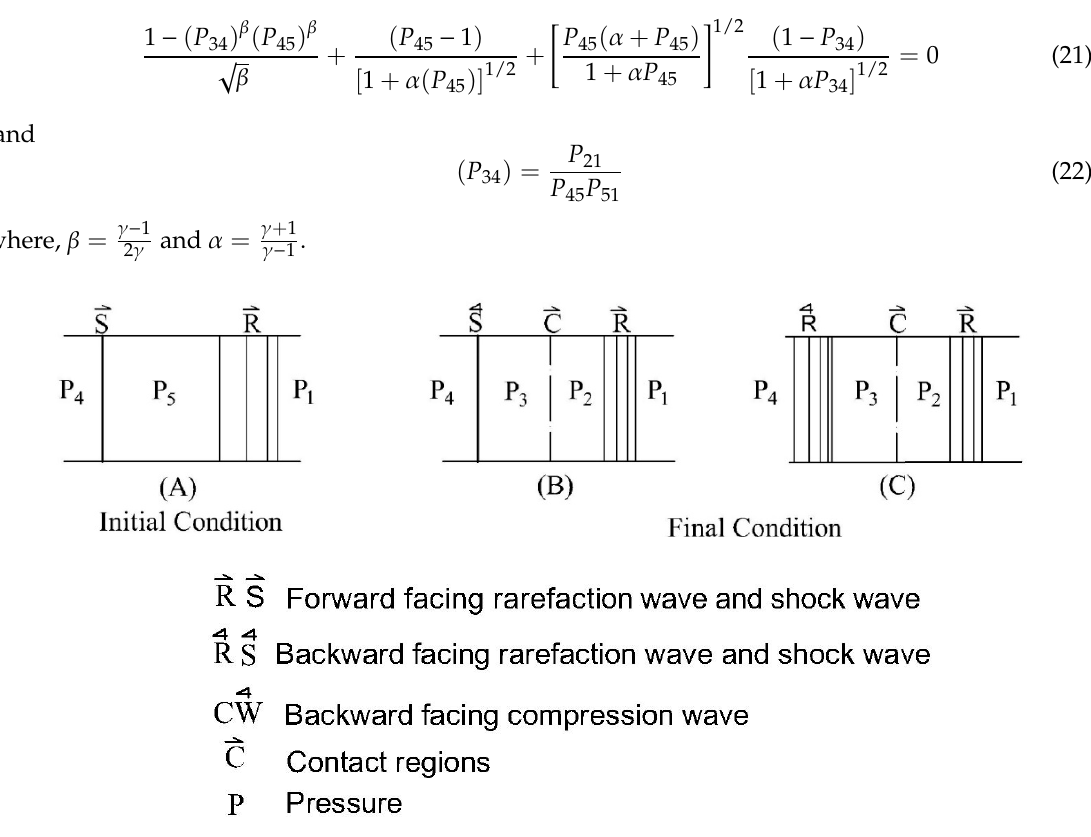
Figure 6. Overtaking of a rarefaction wave by a weak shock wave [Adopted based on a figure in Glass et al (1959)].